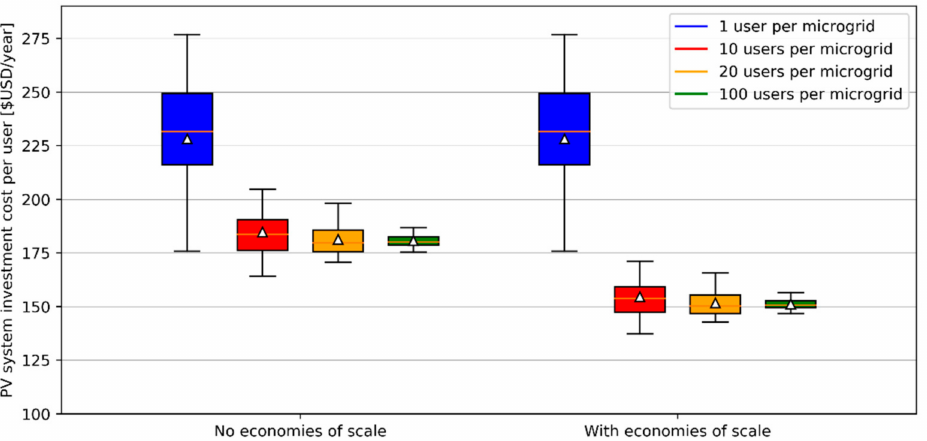
Figure 7. Distribution of investment costs per client for different microgrids, without reliability